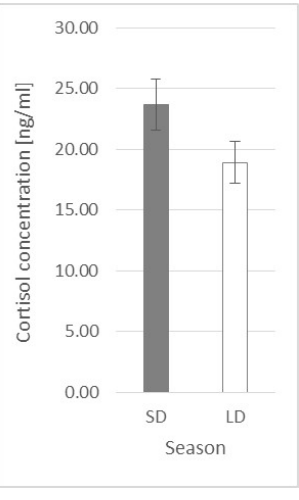
LPS and LEP groups.